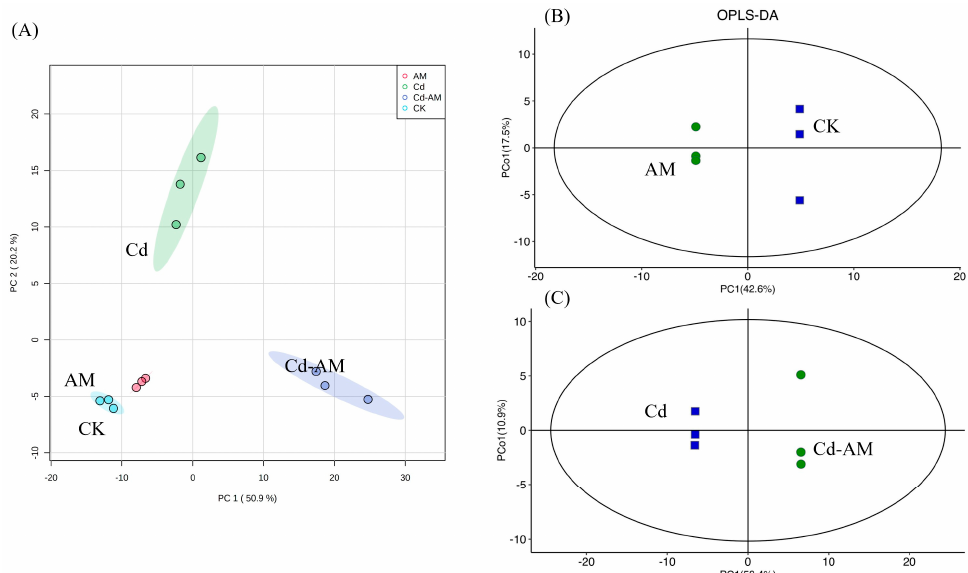
Figure 5. Effect of inoculation with AMF on inter-root metabolites. Principal component analysis (PCA) of the different treatments ( A ). Orthogonal partial least squares discriminant analysis (OPLS- DA) under different treatments: AM vs. CK ( B ), Cd-AM vs. Cd ( C ). The metabolomic dataset was produced through GCMS and then used for the multivariate OPLS-DA modeling (R 2 X = 0.747 Q 2 = 0.996 ( B ) and R 2 X = 0.804 Q 2 = 0.994 ( C )).